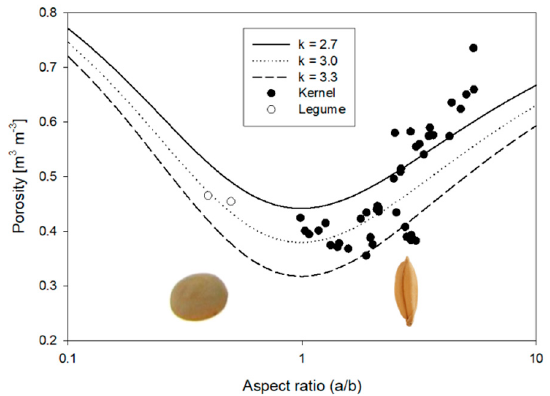
Figure 7. Bulk porosities in various legume ( a < b ) (digitized from [132] ) and grain kernel ( a > b ) (digitized from [130]) packings as a function of legume or kernel aspect ratio. Modeled porosities are shown for a range of scaling coefficients, k, using Equations (19) and (20).